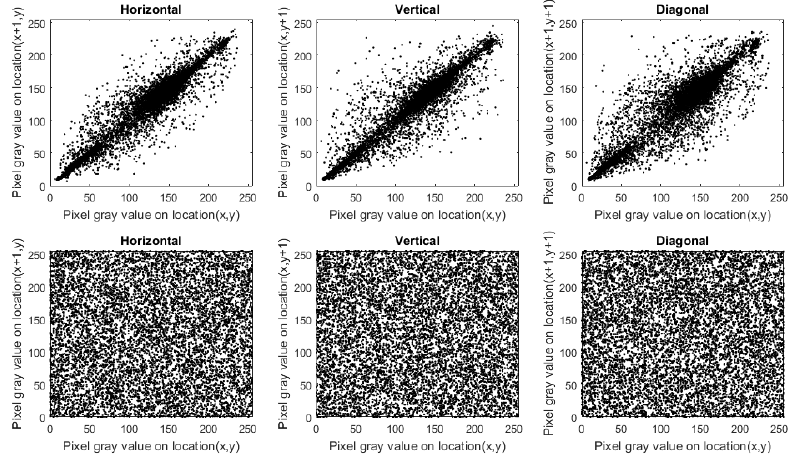
Figure 10. Correlation distribution for OImg04 and its encrypted version before embedding onto the reference image. Table 3. Correlation coefficients for visually encrypted